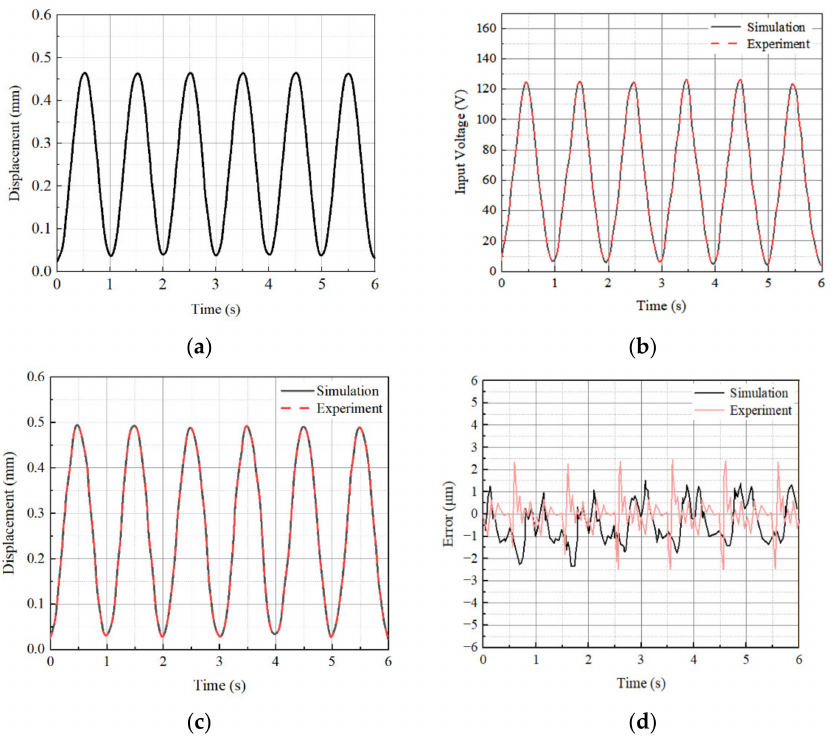
Figure 11. Tracking control results of the spool displacement with sinusoidal trajectory at 100 ◦ C;